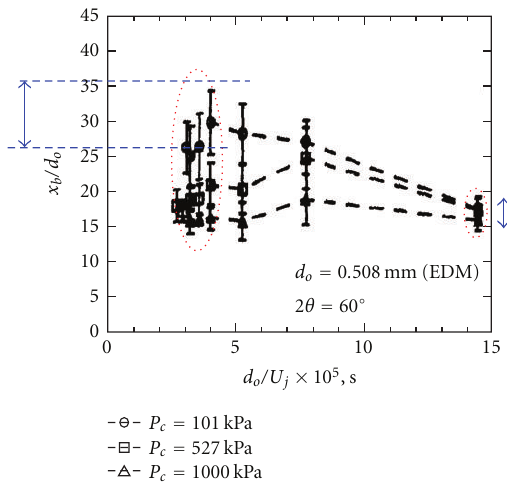
Figure 29: This figure shows sheet break-up length for an impinging injector as a function of instability parameter at three di ff erent chamber pressures. Much higher sensitivity of the sheet break-up length is seen with chamber pressure at low dn / V ( = d o /U j , in the original article) values. Anderson et al.